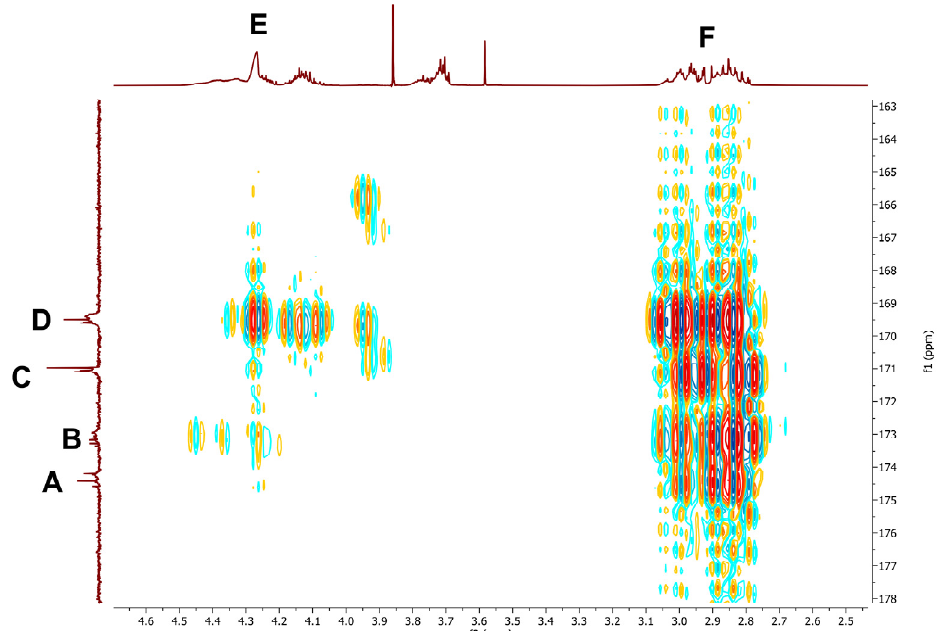
Figure 4. HMBC spectrum of the poly(1,2-ethanediol citrate)—a 1 H– 13 C carbonyl carbon atoms’ correlation fragment.